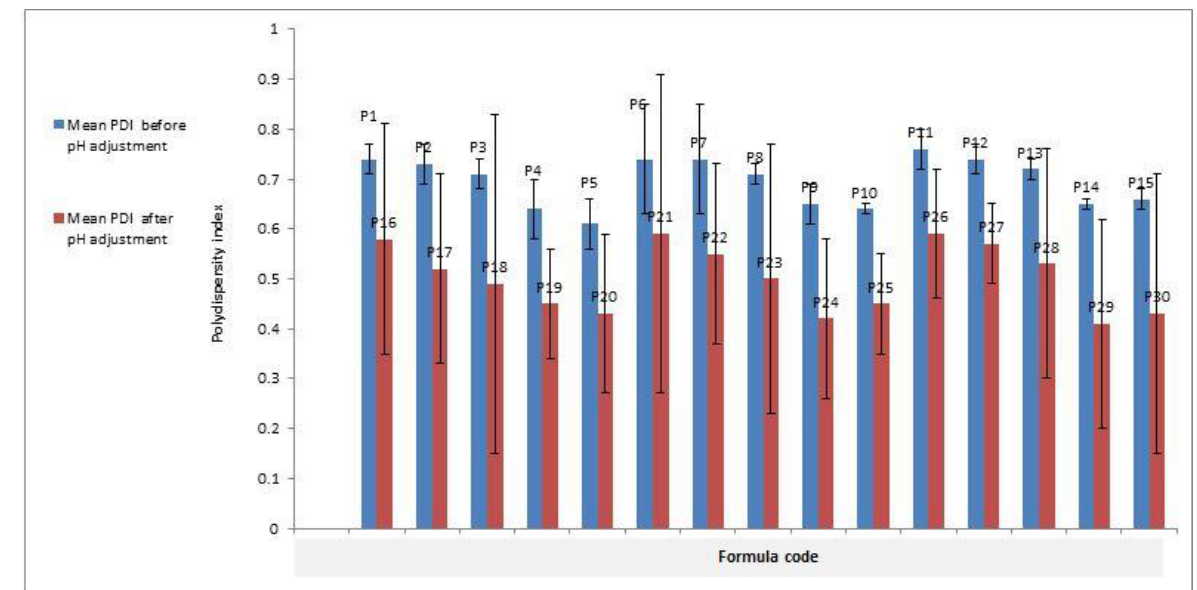
Fig. 2: Effect of pH change of chitosan and TPP solutions on the polydispersity index of drug-free CSNPs